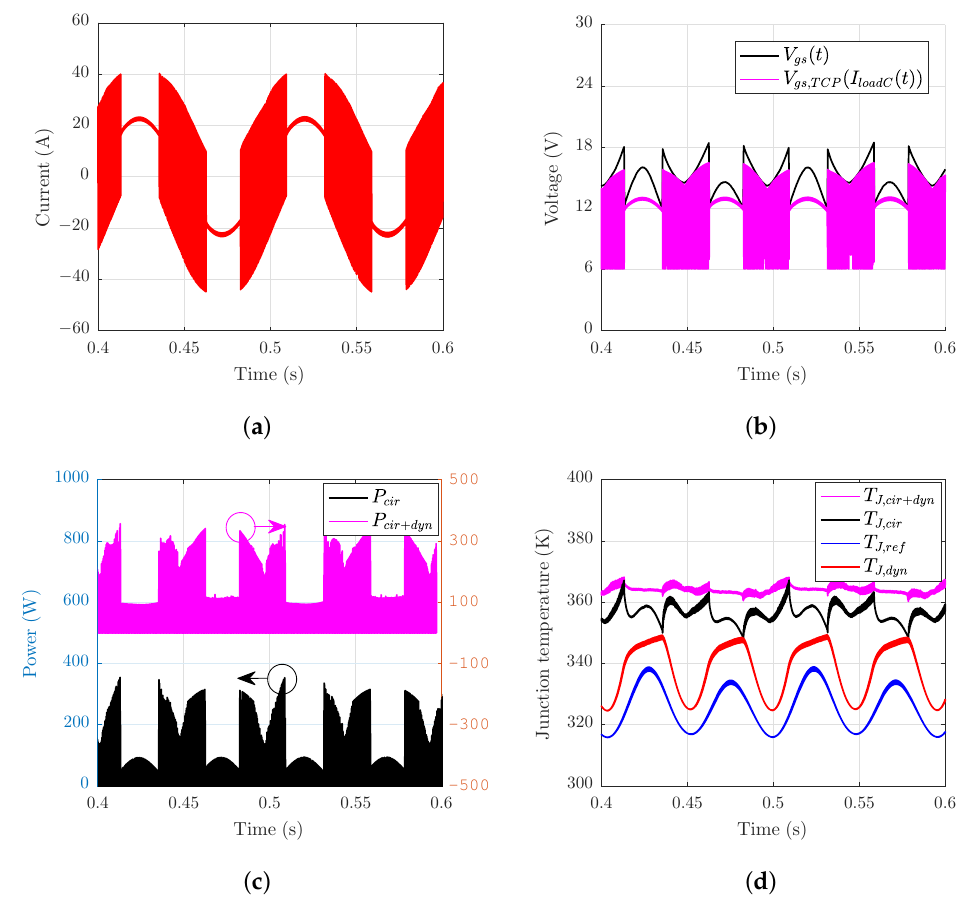
Figure 10. Simulation results of ( a ) inductor current of phase C, ( b ) Dynamic gate voltage profile, ( c ) Conduction losses and ( d ) Junction temperature response with circulation current injection method of the switch